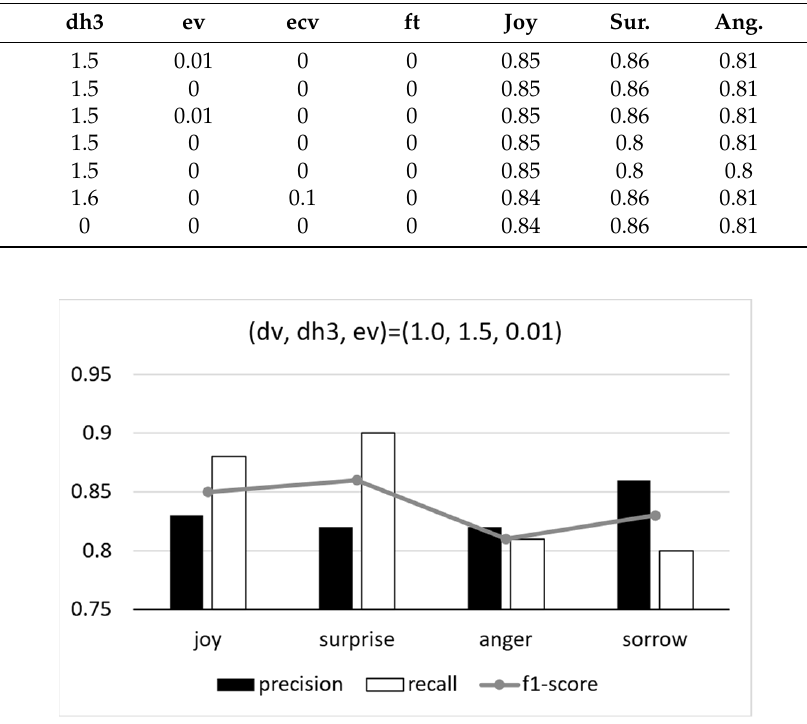
Figure 10. Evaluation results; (dv, dh3, ev) = (1.0, 1.5, 0.01).